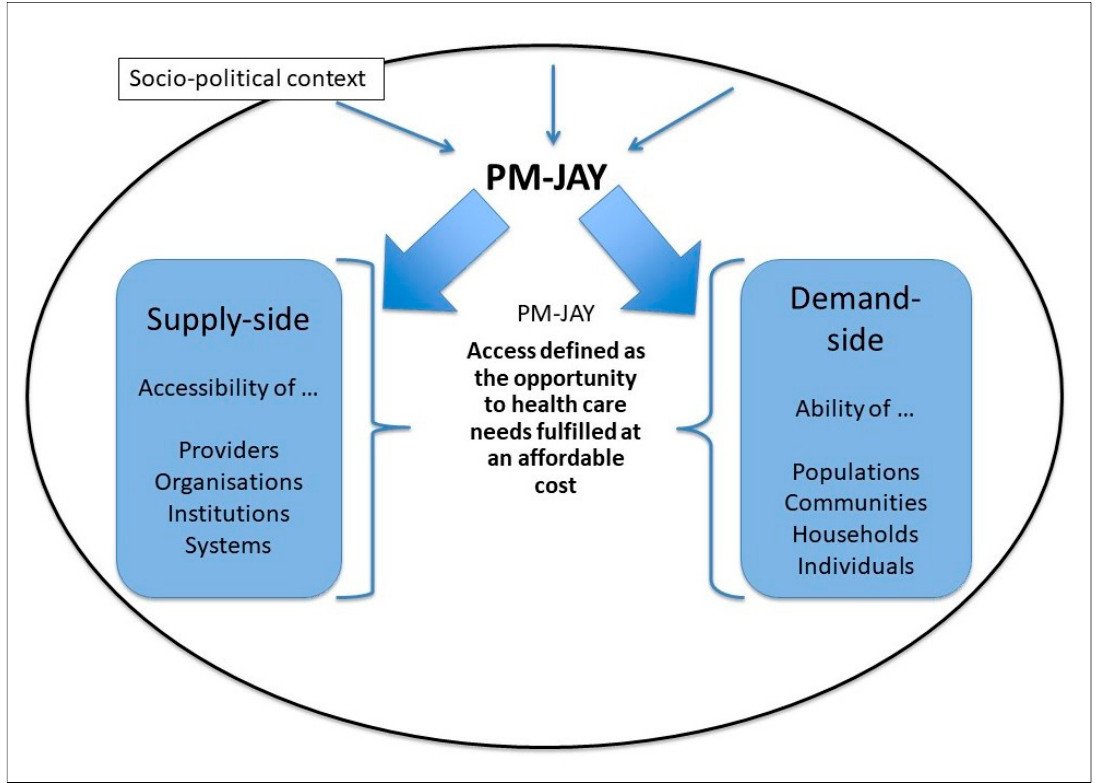
Figure 1. Conceptual framework, adapted from Levesque et al., 2013 [22].